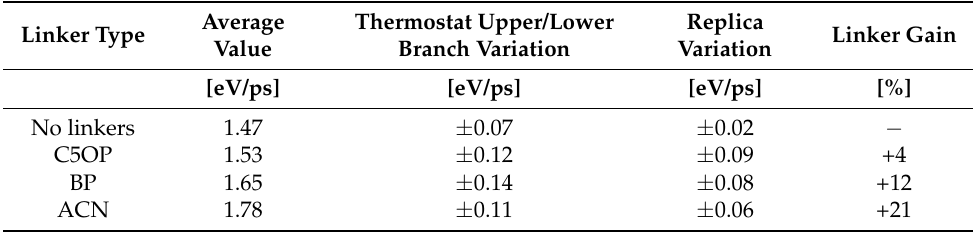
Table 1. Averaged heat flux for different linkers in PDMS. Average value, thermostat variation, replica variation and linker gain as the ratio of linker heat flux over linkerless heat flux